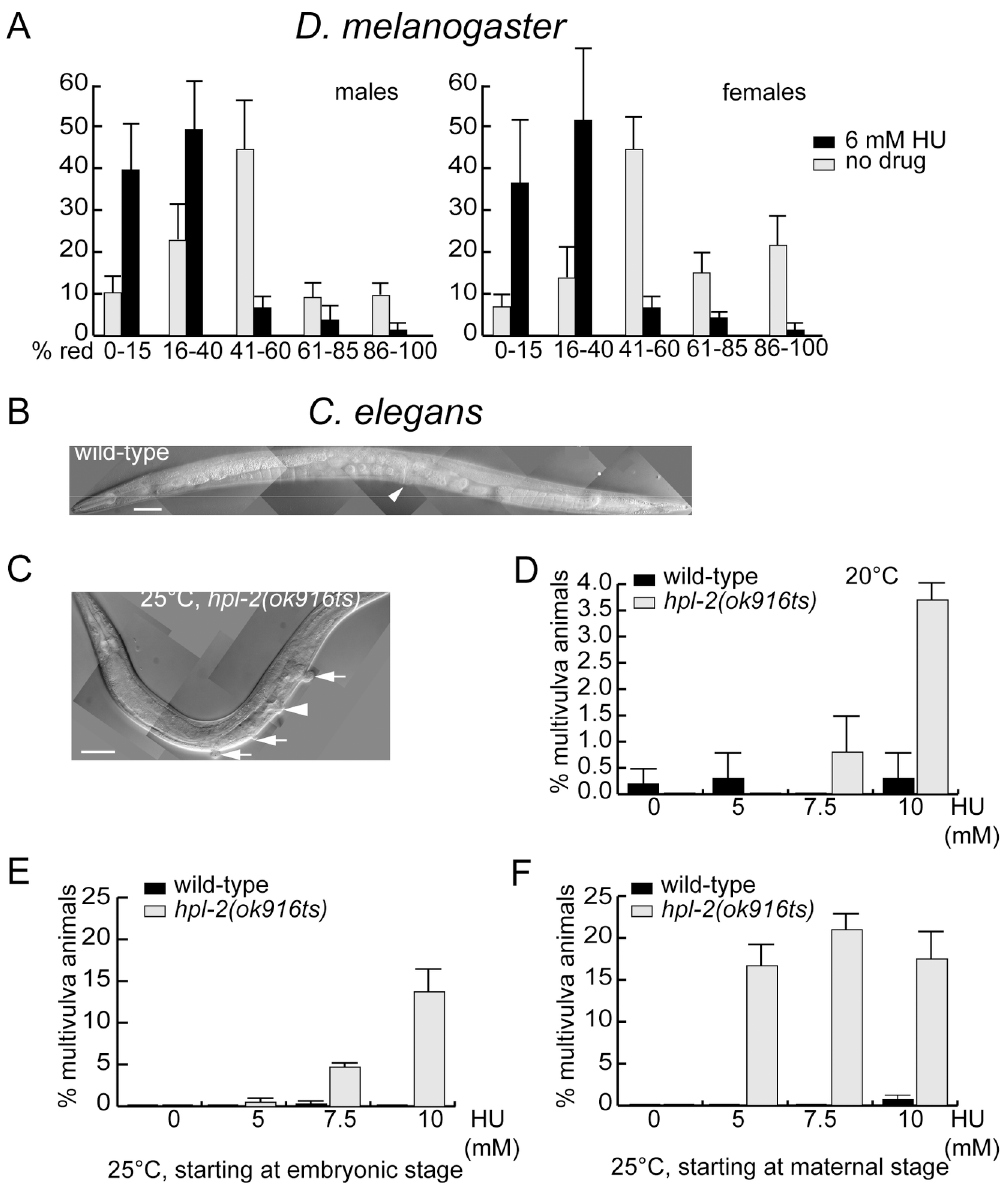
Fig 6. Replication stress affectswhite gene PEV in D . melanogaster and vulva development in C . elegans .(A) HU treatment increasesthe likelihoodof In(1)wm4 silencingin flies. Male or female flies grown without drug (gray bars) or 6 mM HU (black bars) were separated into five bins based on the degreeof eye pigmentation. Bar height is the percentageof the population in that bin for all pooledtrials. The error bars are 1 SD of percentages for four or five independent trials. Total flies assayed: > 500. (B-F) HU treatment inducesa SynMuv phenotype in an hpl-2 mutant worm. (B) Montage of DIC images of a wild-typewith one normal valva (arrowhead)and (C) an hpl-2 mutant adult raisedon 10mM HU plate, with three vulva-likestructures (arrows). Scale bars are 50 mms. (D-F) Synchronized L1 larvaewere placed on NGM plates containing HU as labeled,the multivulva phenotype was scored after worms reachedadulthood.Each data point is represented as mean ± SD. In (D), the animalsfor scoringand their mothers were raised at 20˚C; in (E), mothers were raised at 20˚C, and the animalsfor scoring were raised at 25˚C, start at the embryonic stage; in (F), the animalsfor scoringand their mothers were all raised at 25˚C.